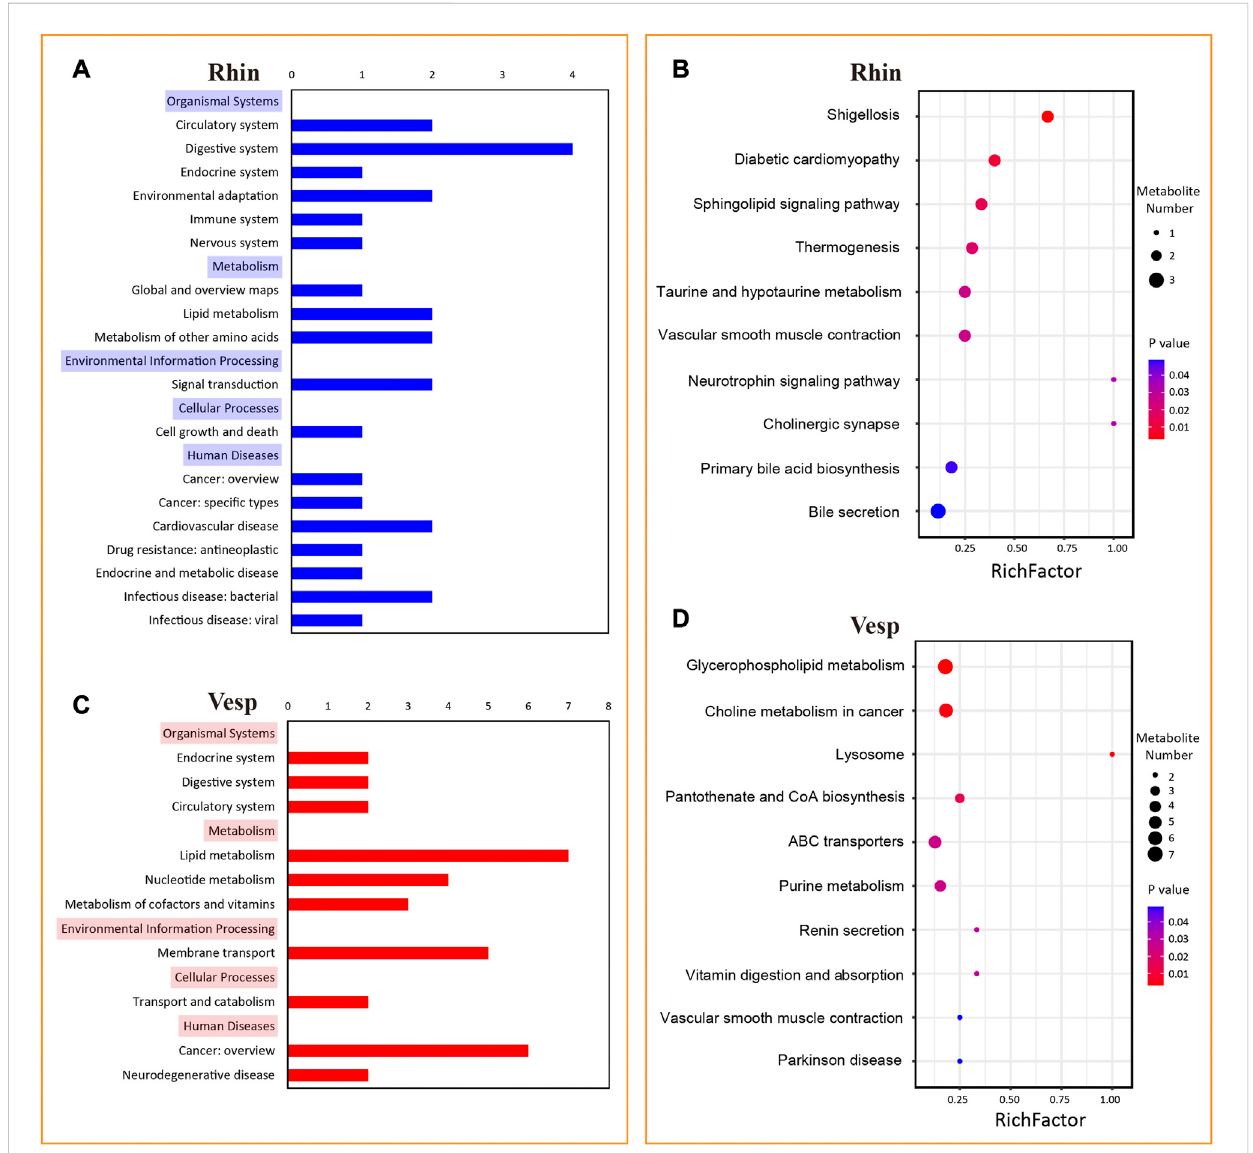
FIGURE 6 KEGG pathways signi fi cantly associated with 129 and 228 DAMs with signi fi cantly abundant levels in the cochleae of R. sinicus and V. sinensis , respectively. (A) and (C) KEGG A and B categories signi fi cantly associated with DAMs for R. sinicus and V. sinensis . (B) and (D) The top 10 KEGG pathways signi fi cantly associated with DAMs for R. sinicus and V. sinensis